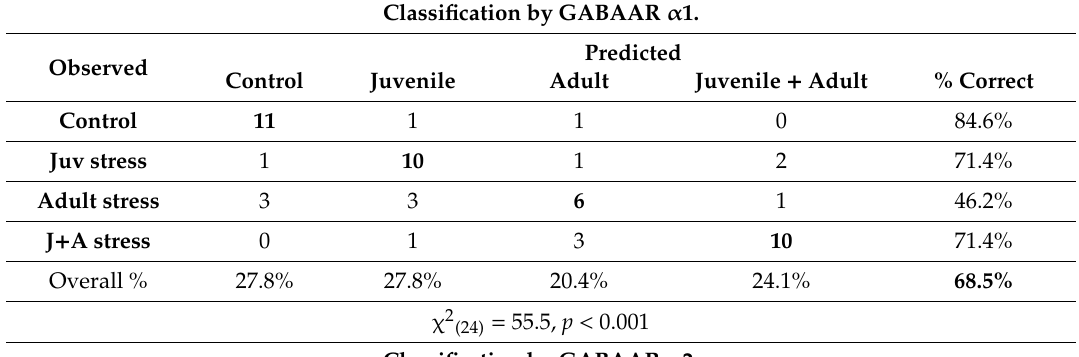
Table A2. Classification successes and significant e ff ects of multinomial logistic regression analyses conducted by separate receptors type.